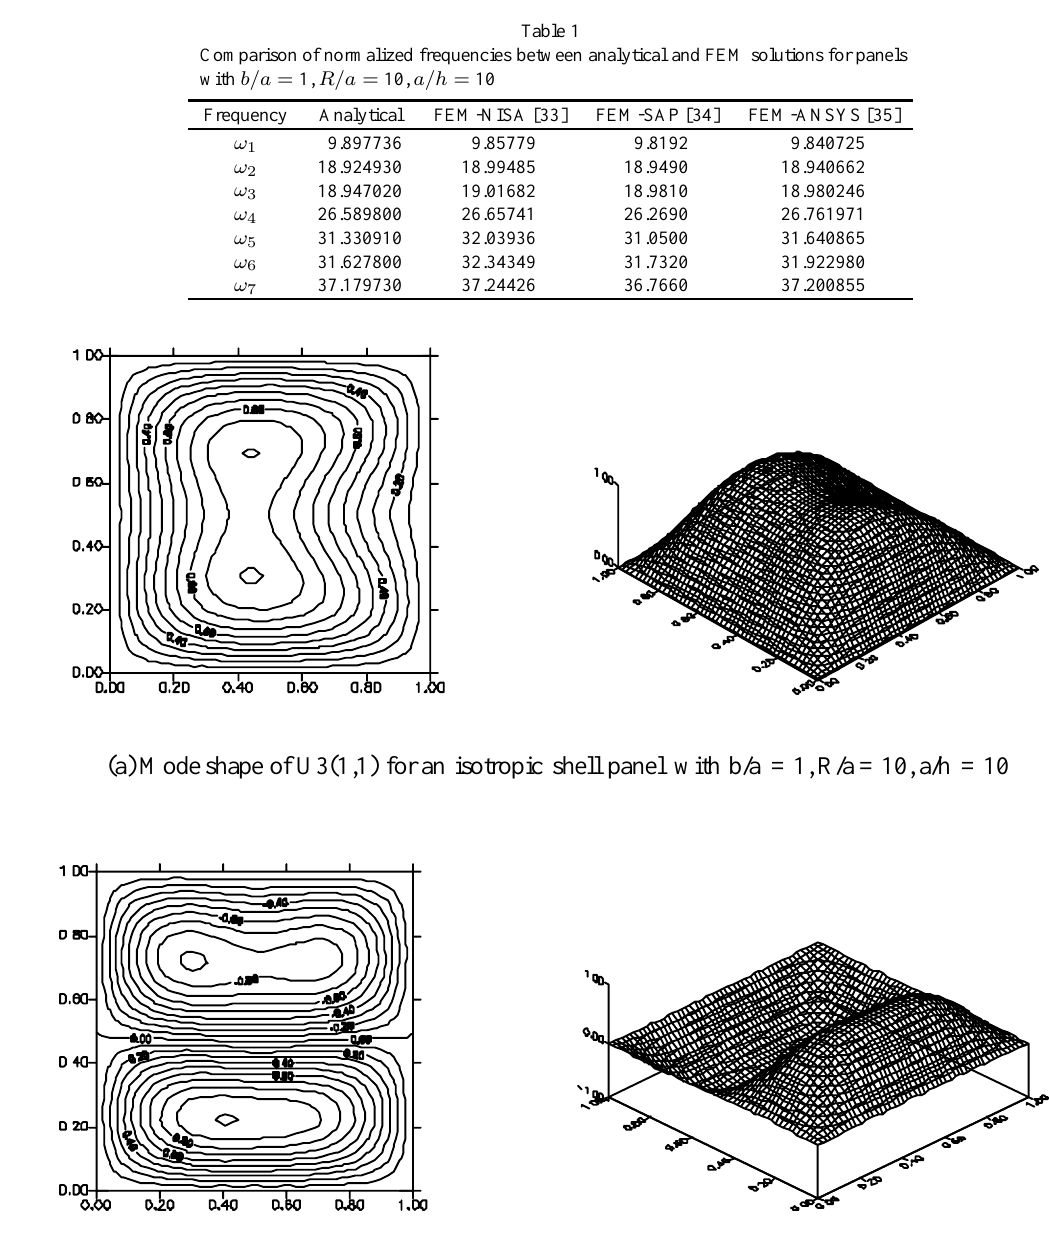
Fig. 5. (a). Mode shape of U3(1,1) for an isotropic shell panel with b/a = 1, R/a = 10, a/h = 10. (b). Mode shape of U3(1,2) for an isotropic shell panel with b/a = 1, R/a = 10, a/h =